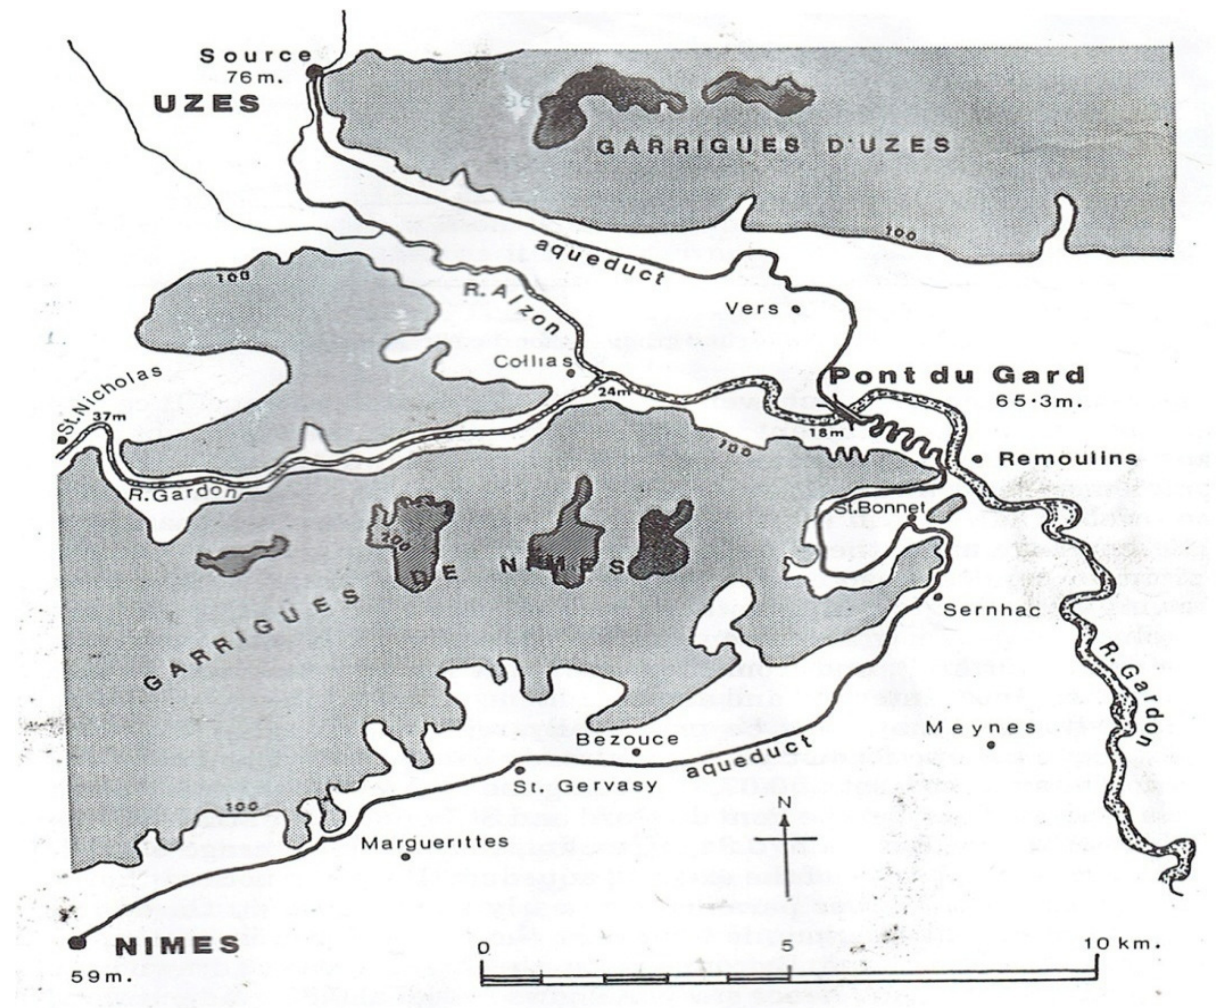
Figure 1. Map of the Pont du Gard aqueduct water system path from the Fontaine d’Eure source spring at Uzes to the destination castellum .